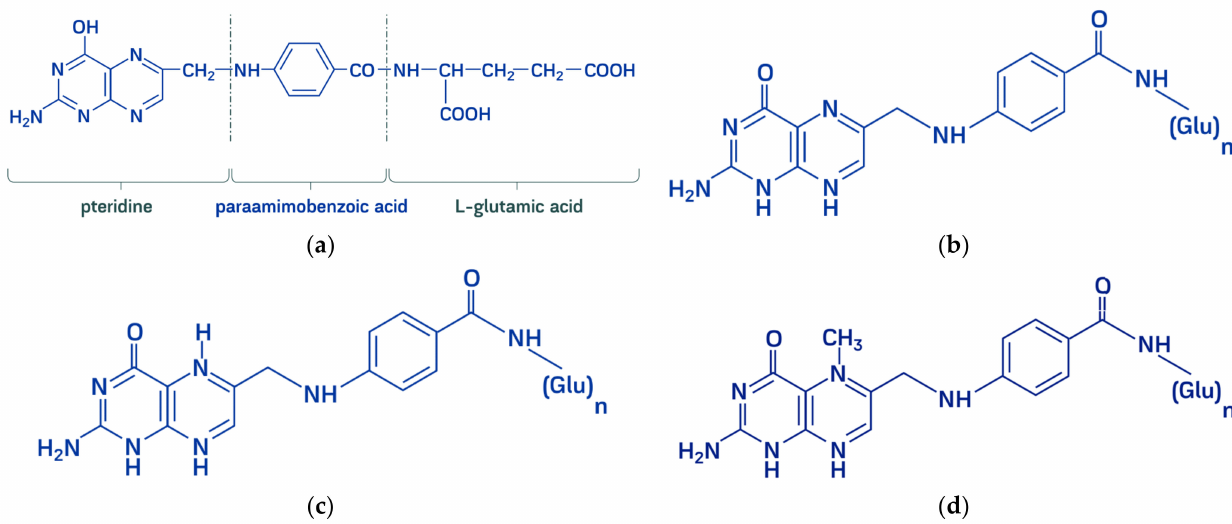
Figure 1. Chemical structure of ( a ) folic acid and its metabolically active derivates: ( b ) dihydrofolate, ( c ) tetrahydrofolic acid, ( d )